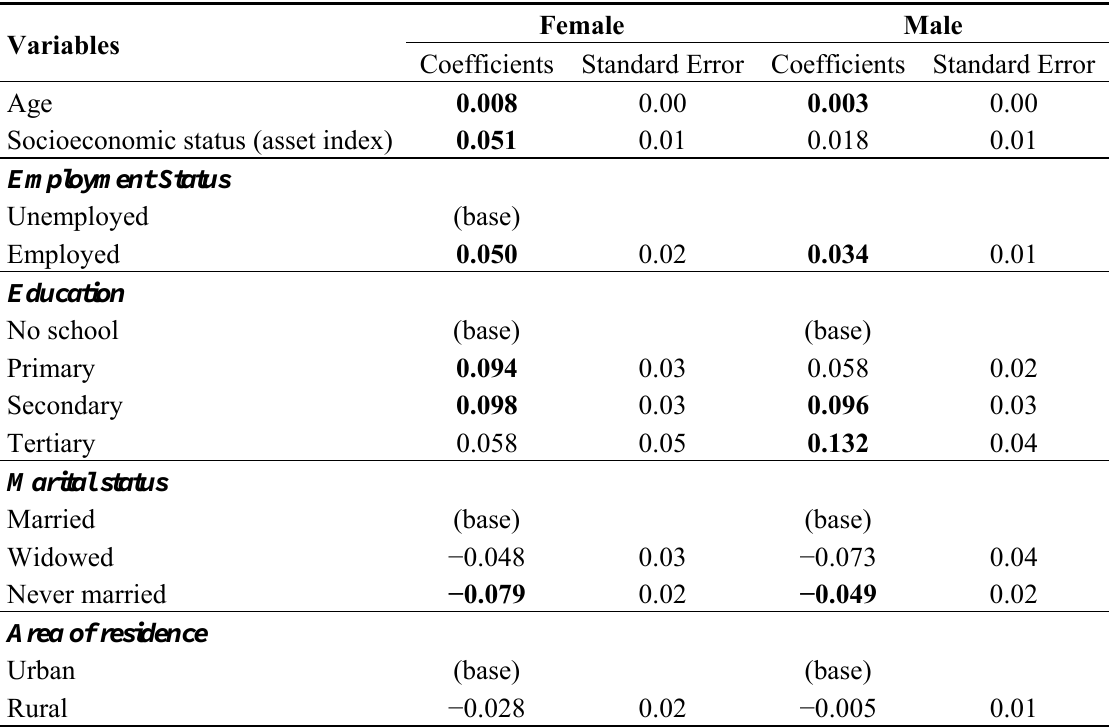
Table 3. Results of the linear probability regression